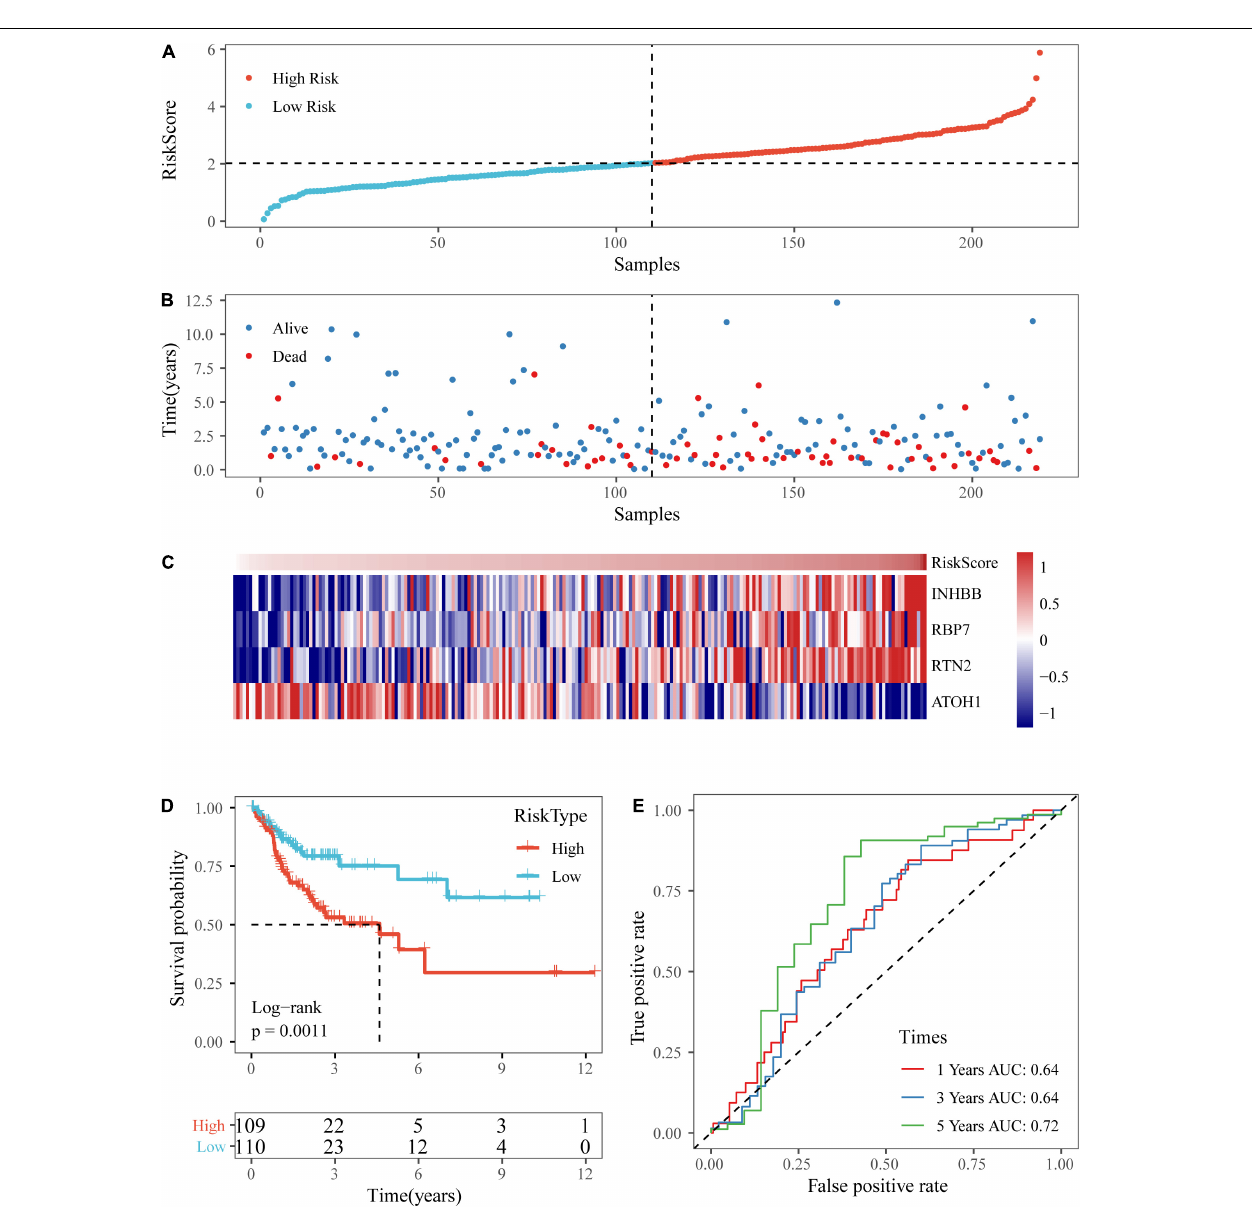
FIGURE 7 | Verification of the four-gene signature in TCGA test datasets. (A,B) The distribution of risk scores in TCGA test dataset and the distribution of corresponding survival states. (C) Heatmaps of gene expression in the risk score model. (D,E) KM curves and ROC curves of the risk score in TCGA test datasets.